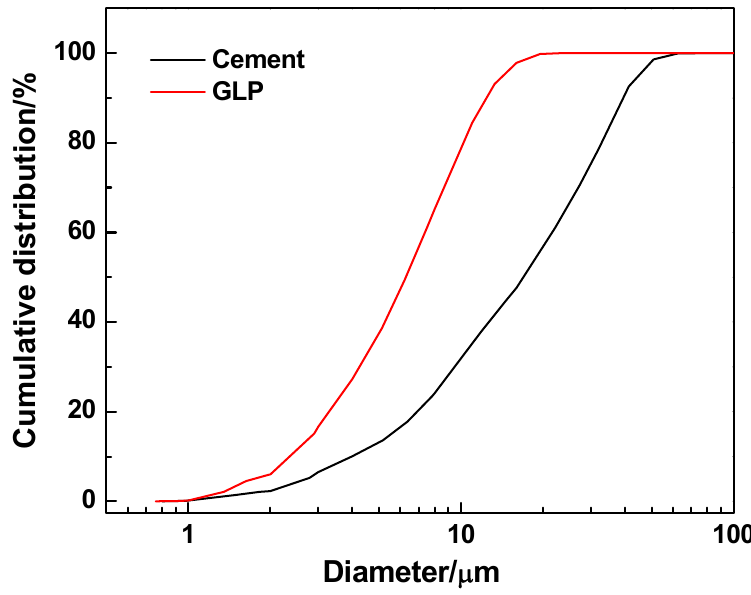
Figure 3. The particle size distributions of cement and GLP.